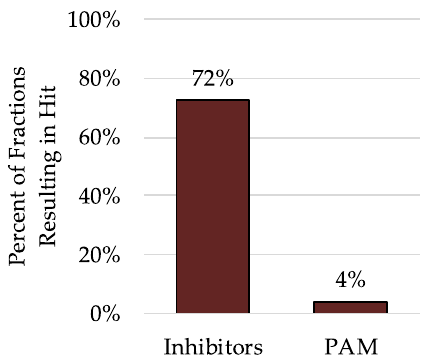
Figure 5. Percent of fractions resulting in a traditional hit (inhibits radioligand binding >50%), or a positive allosteric modulator (increases radioligand binding >50%).